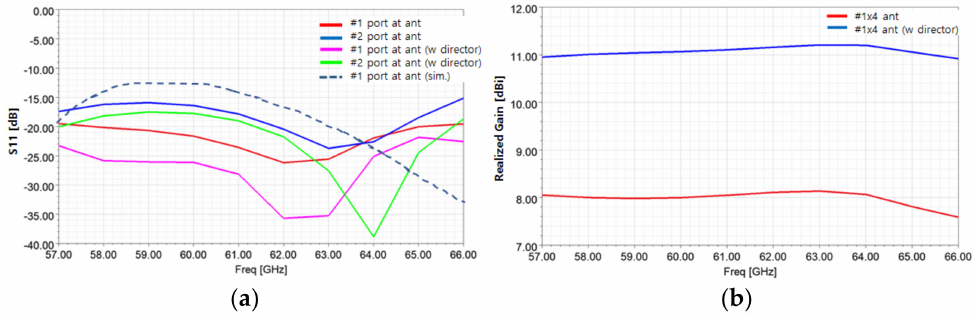
Figure 6. Measurement results of ( a ) return loss and ( b ) realized